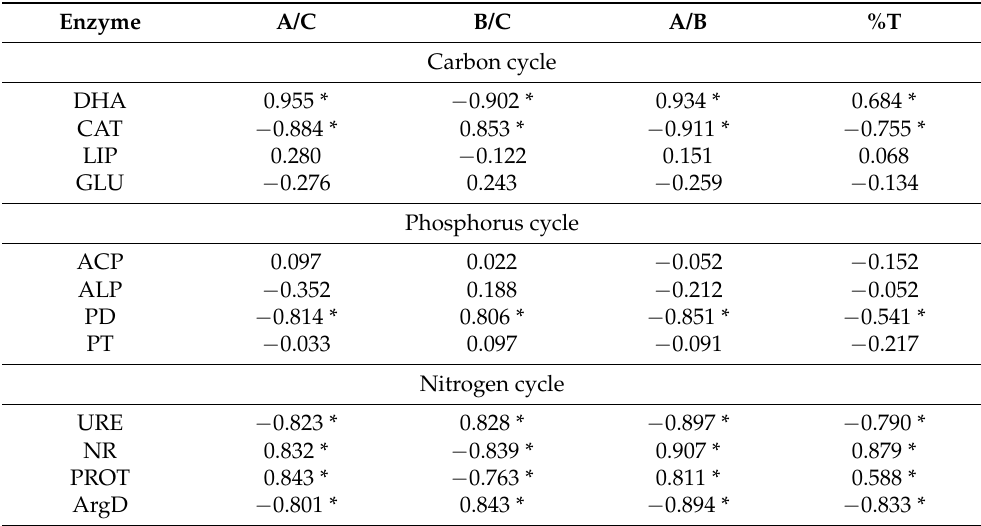
Table 6. Pearson correlation coefficients for the relationship between enzyme activity and organic matter characterization and ecotoxicity to A. fischeri of the soil samples exposed to tetrabutylphos- phonium bromide [TBP][Br] in pot experiment with spring